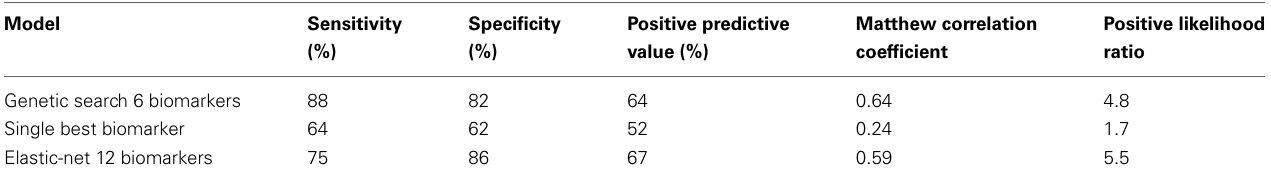
Table 3 | Overview of classification results [classification based on testing subjects that were not used for training the classifier (MCI-stable, n = 22; AD-convert, n = 8)].